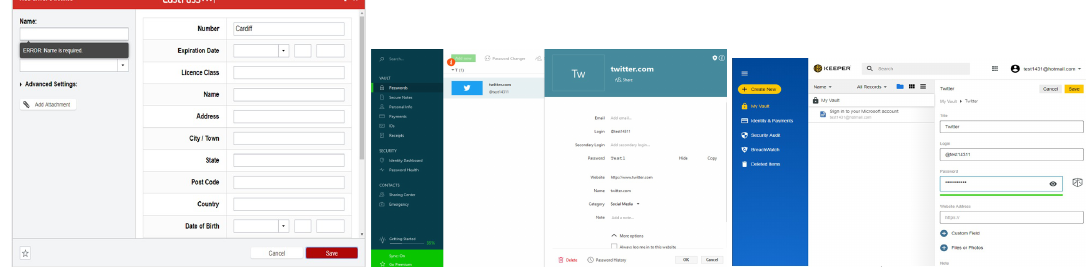
Figure A2. Data entry forms in LastPass, Dashlane and Keeper, which do not have asterisks. Part of password in Dashlane is